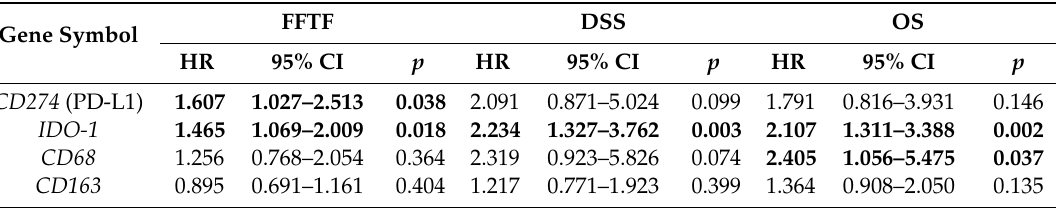
Table 2. Cox regression analysis as continuous variable at univariate level showing association of gene expression levels with FFTF, DSS and